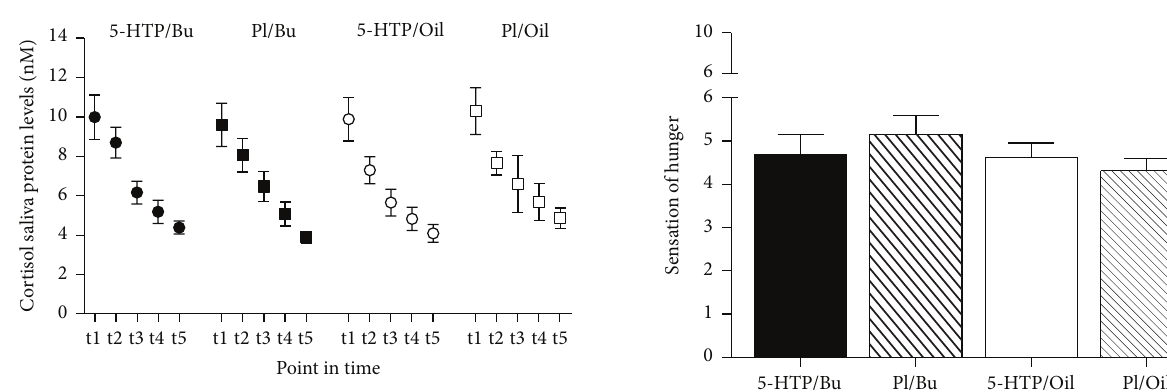
Figure 5: Hunger rating. The influence of 5-hydroxytryptophan (5-HTP) and fatty acid ingestion on the sensation of hunger. Participants received a capsule with either 5-HTP or placebo (Pl). They also ingested a standard breakfast supplemented with 100 𝜇 L 13 C octanoid acid and either butter (Bu) or olive oil (Oil). Over the next 24 hours, the sensation of hunger was recorded using a scale ranging between 0 (no sensation of hunger) and 10 (strong sensation of hunger). The data are presented as means ± SE. Statistics: no statistical